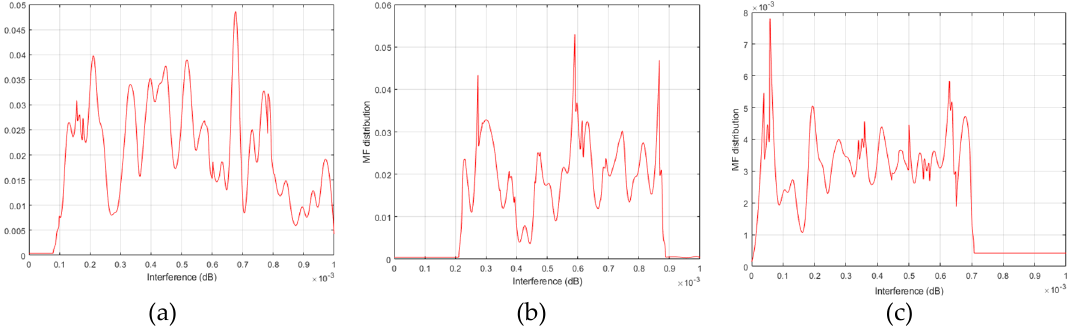
= 6 × 10 − 6 W, ( b ) E = 0.5 J, ( c ) T = 5 s. max max